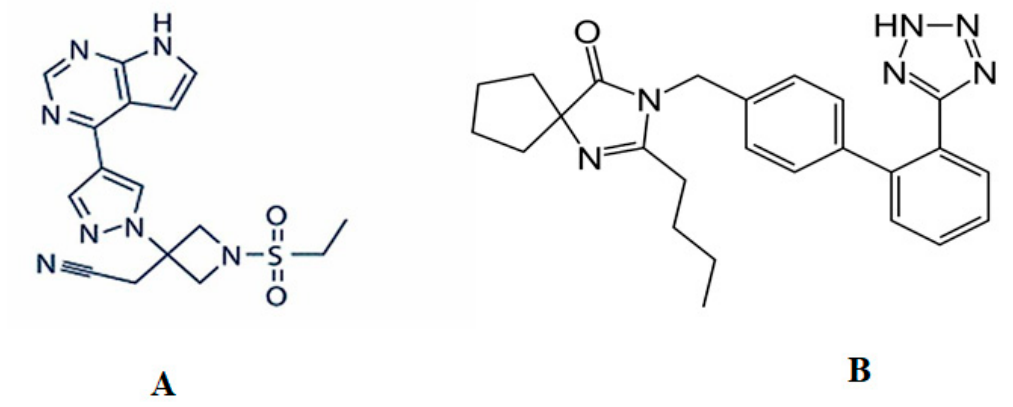
Figure 1. Chemical structures of baricitinib ( A ) and irbesartan ( B ).